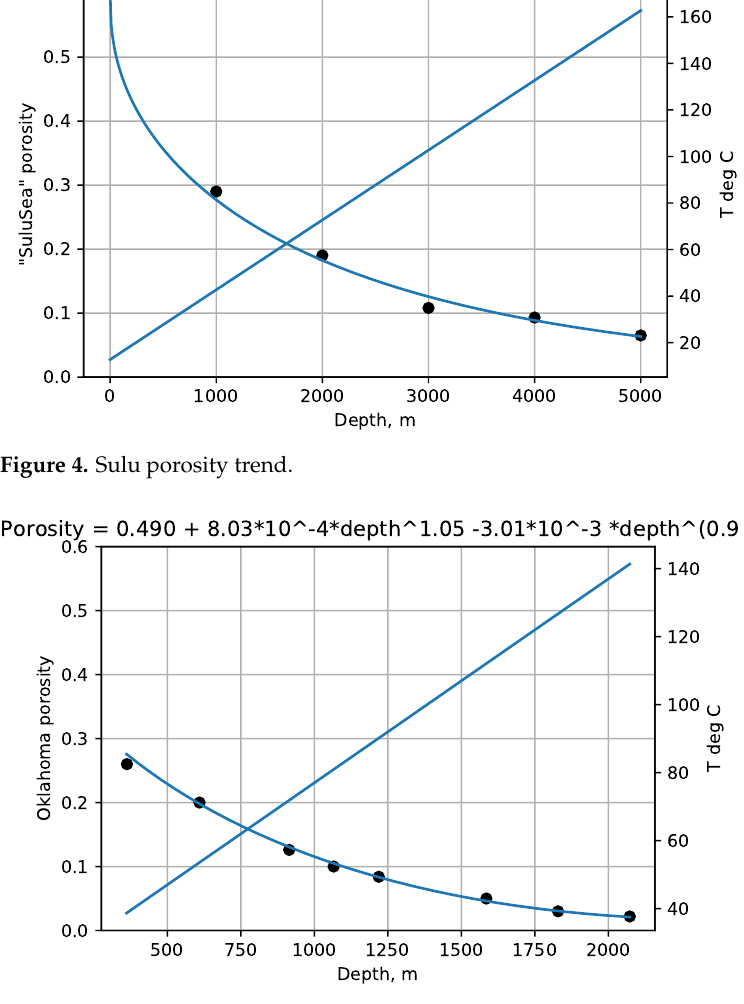
Figure 5. Oklahoma porosity